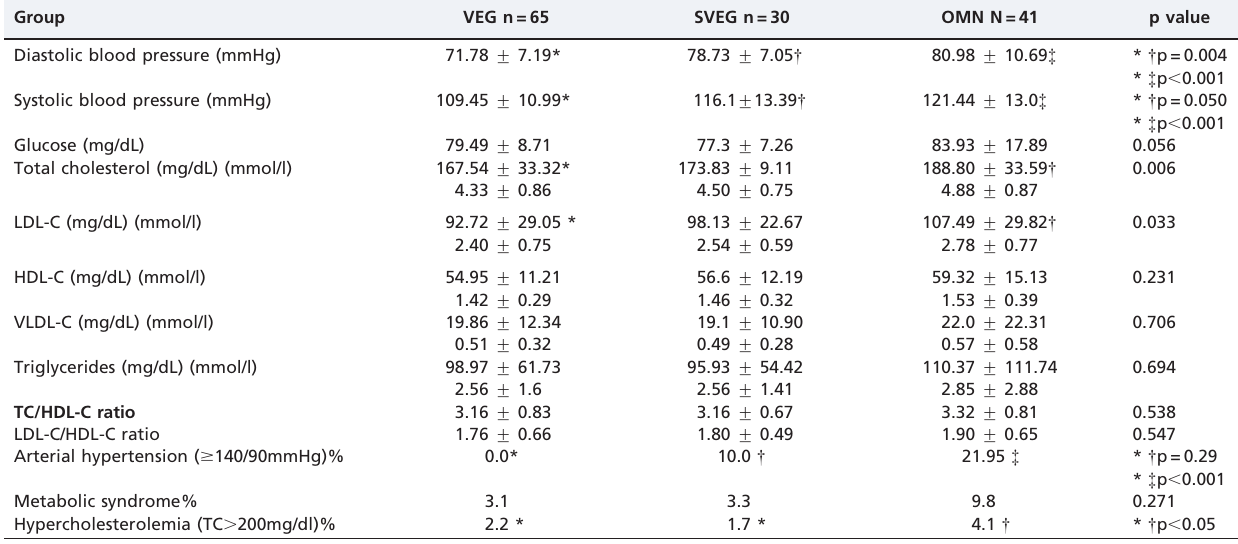
Means and percentages with different signs are significantly different from each other; p , 0.05 (Scheffe’s test for ANOVA for means and Fisher’s exact test for percentages). VEG=vegetarians, SVEG=semi-vegetarians, OMN=omnivorous; HDL-C=high-density-lipoprotein cholesterol; LDL-C=low-density- lipoprotein cholesterol; VLDL-C=very low-density-lipoprotein cholesterol; TC=total cholesterol.